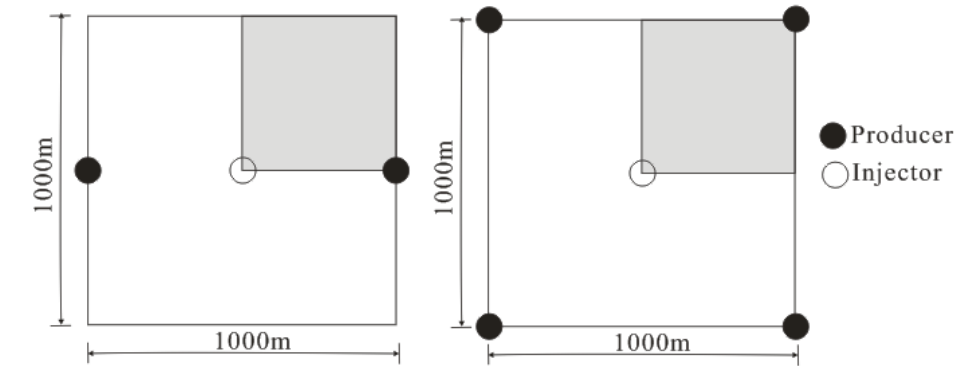
Figure 1. The EGSs of three vertical wells and five vertical wells.